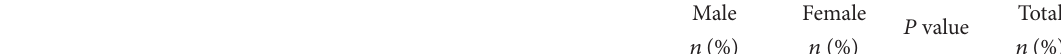
Table 2: Patients’ perception about the role of medical students and residents in the operation theatre.